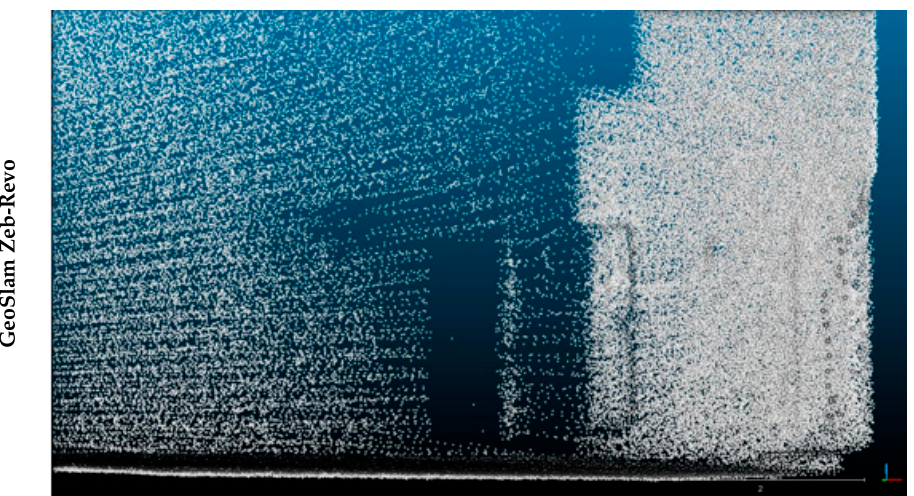
Figure 20. Area chosen for assessing the recognizability of architectural details in the clouds.